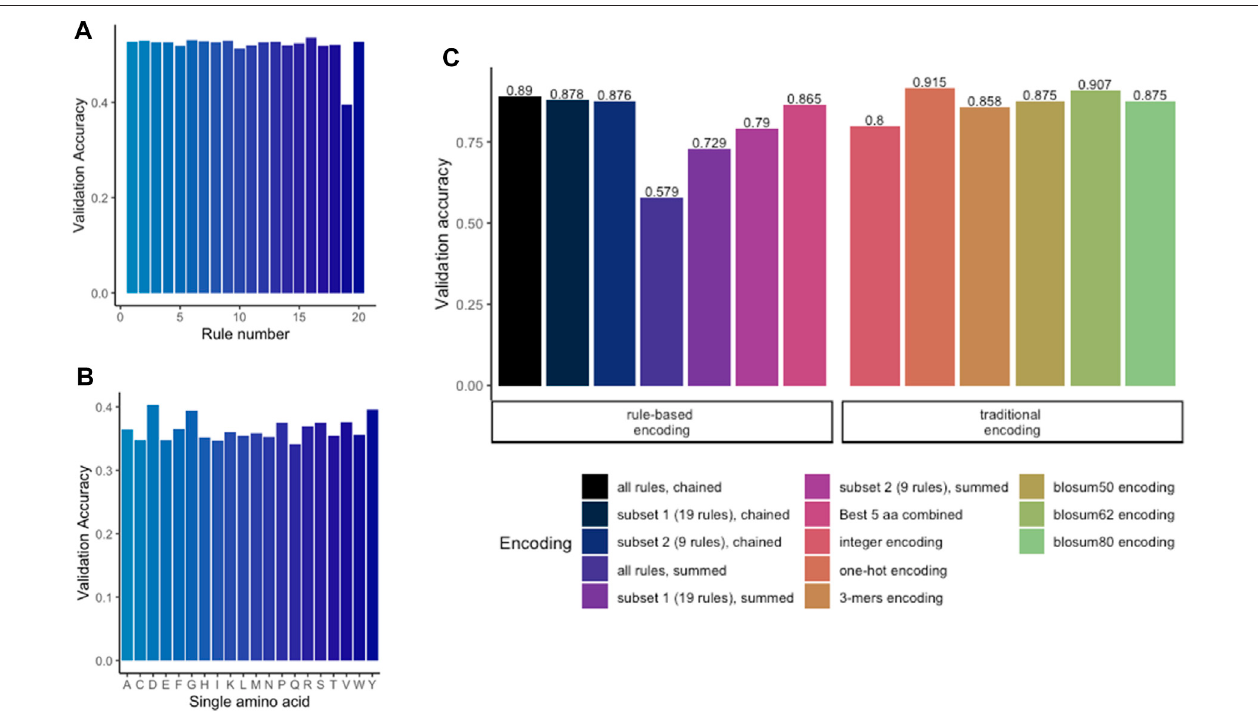
FIGURE 3 | Benchmarking of encoding methods. (A) Validation accuracy for random chaining of fi ve physicochemical rules. (B) Validation accuracy for encoding with only one single amino acid per model. (C) Comparing the rule-based methods with traditional methods revealed that one-hot encoding achieved the highest accuracy. Highest accuracy among the rule-based encoding is achieved by chaining the subset of 19